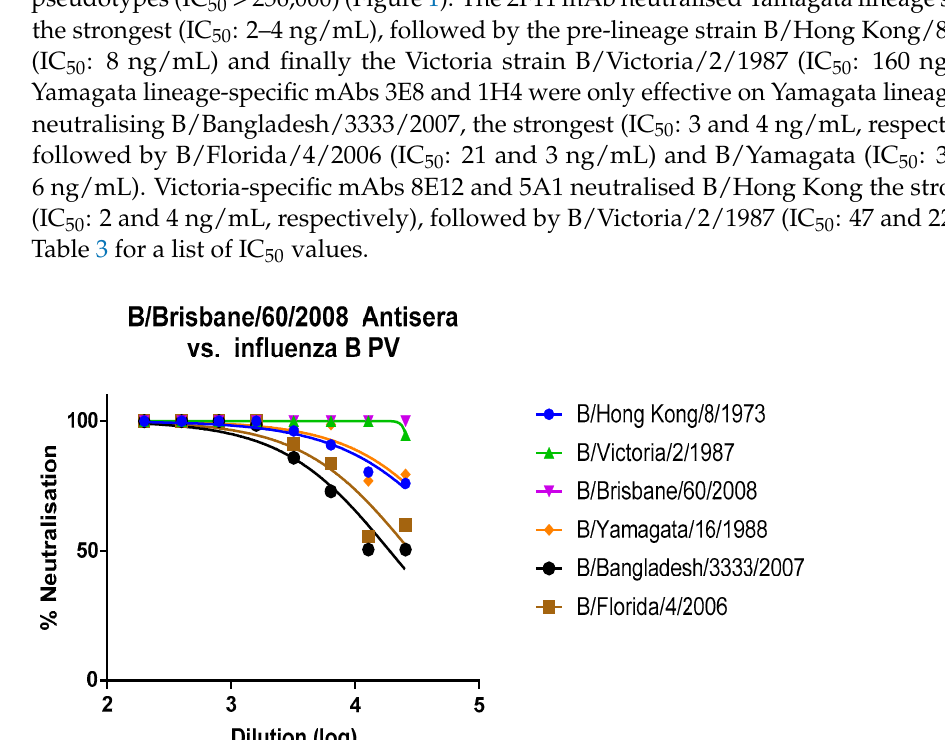
Figure 2. pMN neutralisation curves for FDA mAbs 2F11, 3E8, 1H4, 8E12 and 5A1 against PV bearing the HA glycoprotein from the influenza B pre-lineage split strain, B/Hong Kong/8/1973. This PV is neutralised strongly by Victoria-specific mAbs 5A1, 8E12 and cross-lineage mAb 2F11 but not Yamagata specific mAbs 3E8 or 1H4.